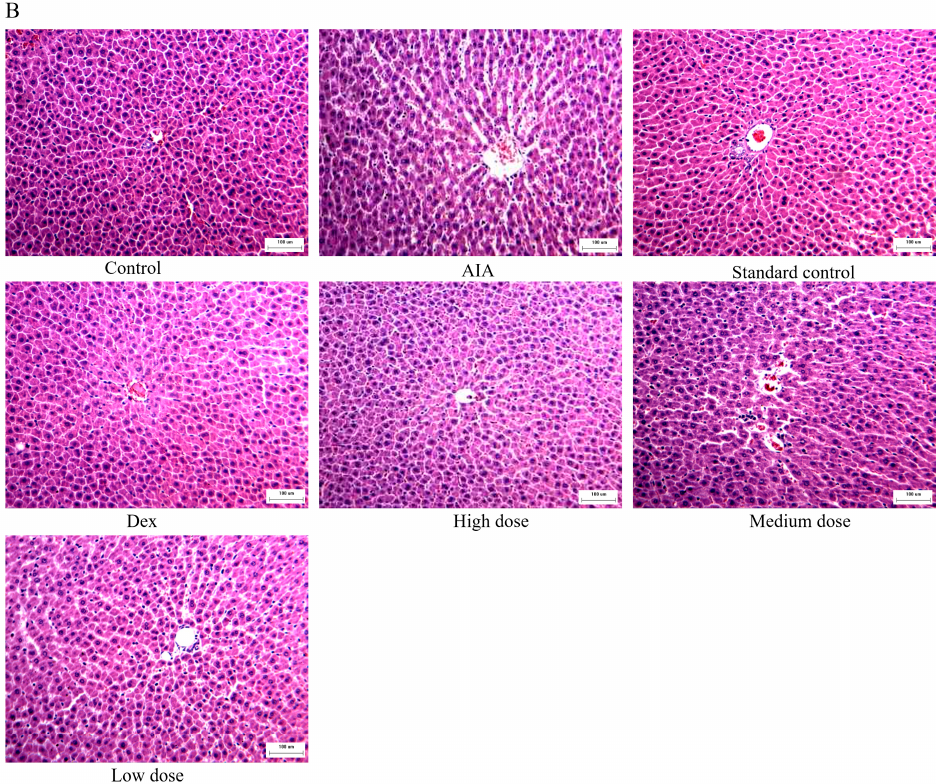
Figure 4. The influence on the liver and spleen after purpurin administration. ( A ) H&E staining of the spleen (magnification: 100-fold). ( B ) H&E staining of the liver (magnification: 100-fold). Dex: